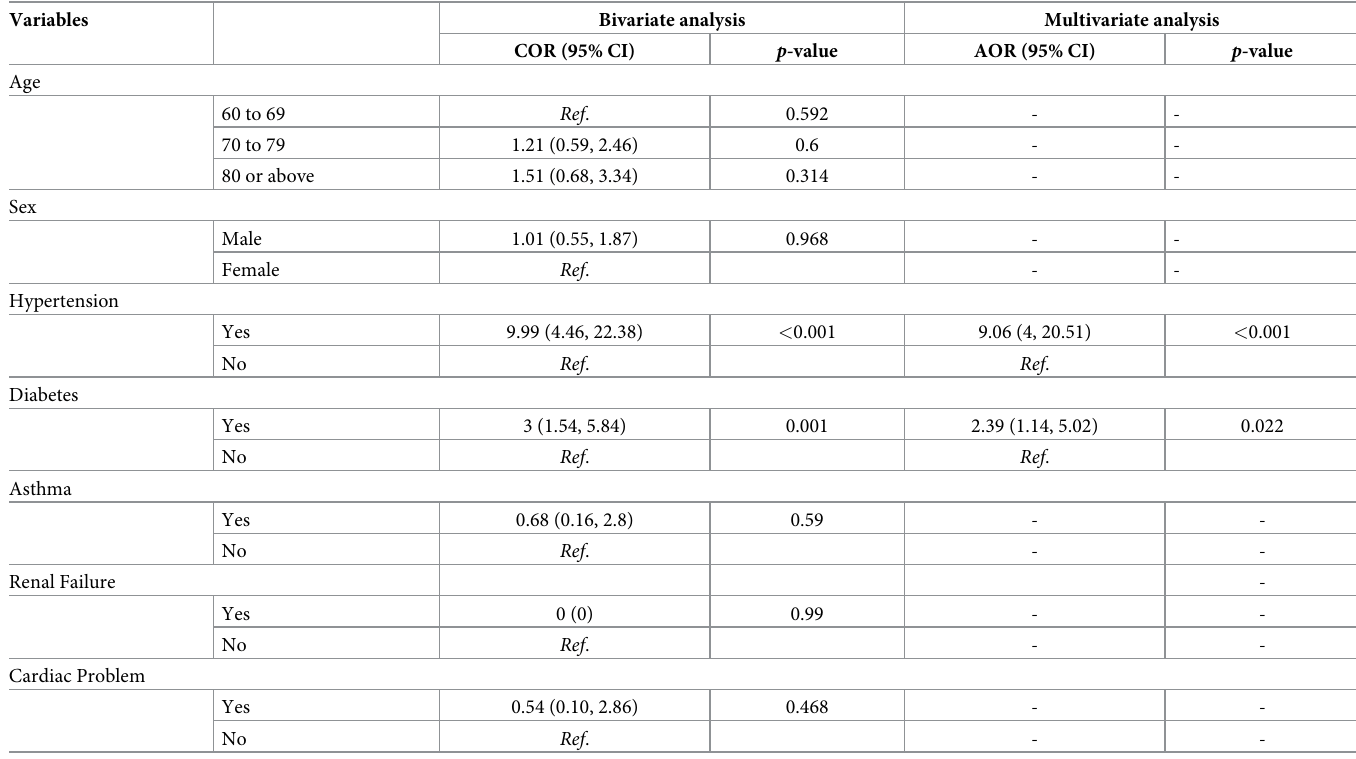
Table 4. Associations of chronic NSAID users with age, gender, and chronic illnesses.